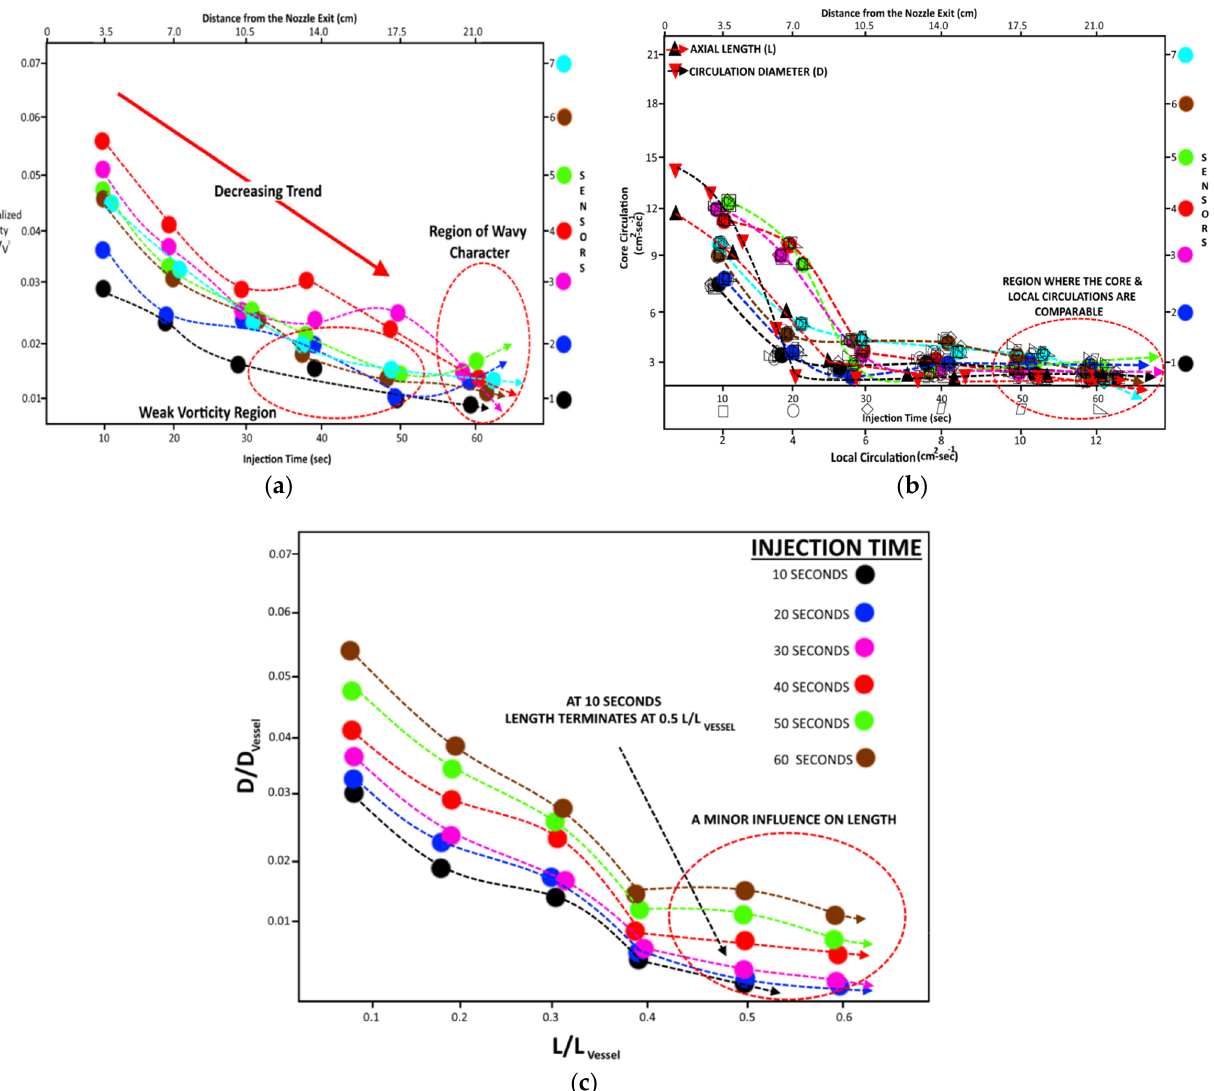
Figure 2. ( a ). Normalized vorticity along the flow channel.( b ). Core vs. central circulation of steam–water flow.( c ). Dependence of length and diameter on the injection time.